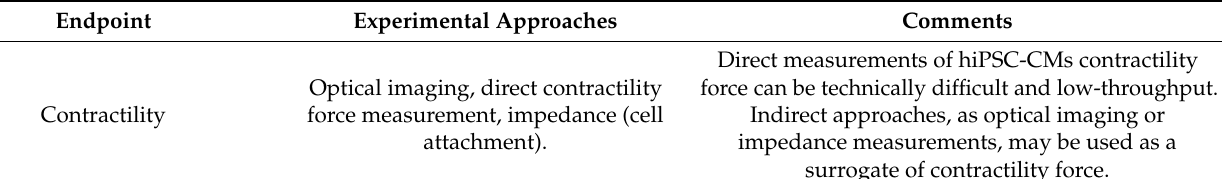
Table 2. List of potential chronic cardiotoxicity